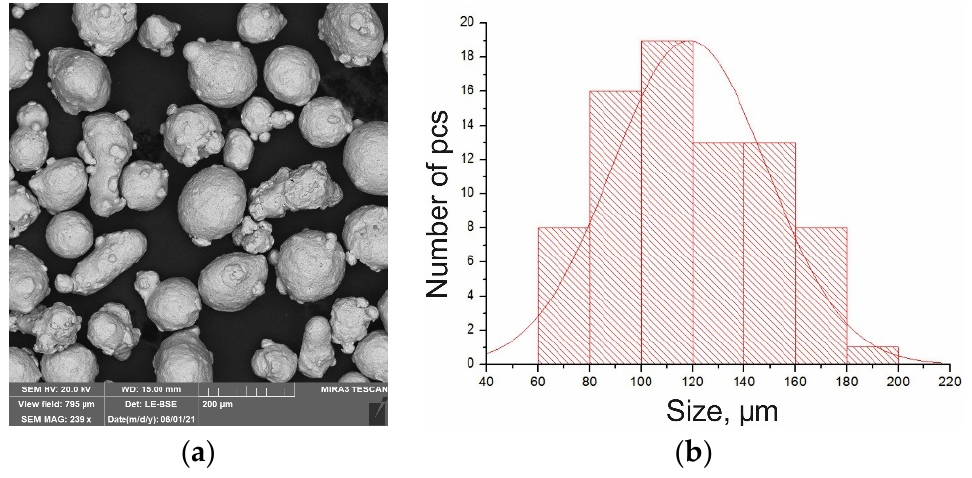
Figure 2. Powder 316L: ( a ) powder particles; ( b ) particle histogram.